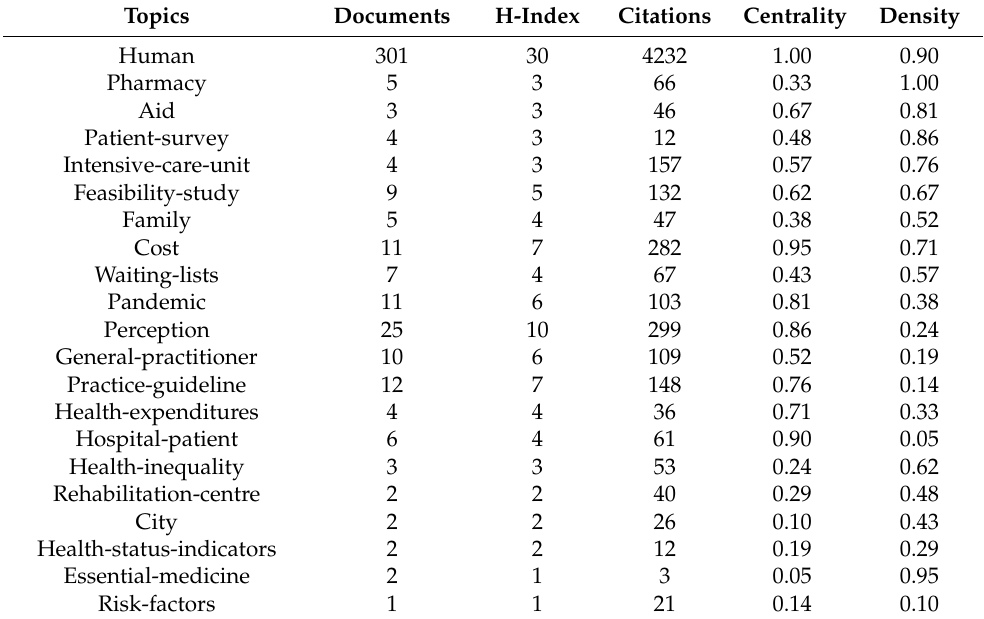
Table 9. The characteristic of the strategic diagram topics from 2011 to